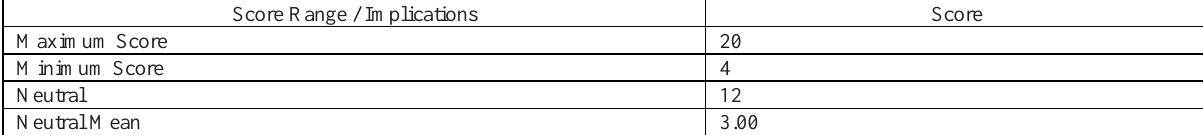
Table 1. Showing Shopping Preference Scores